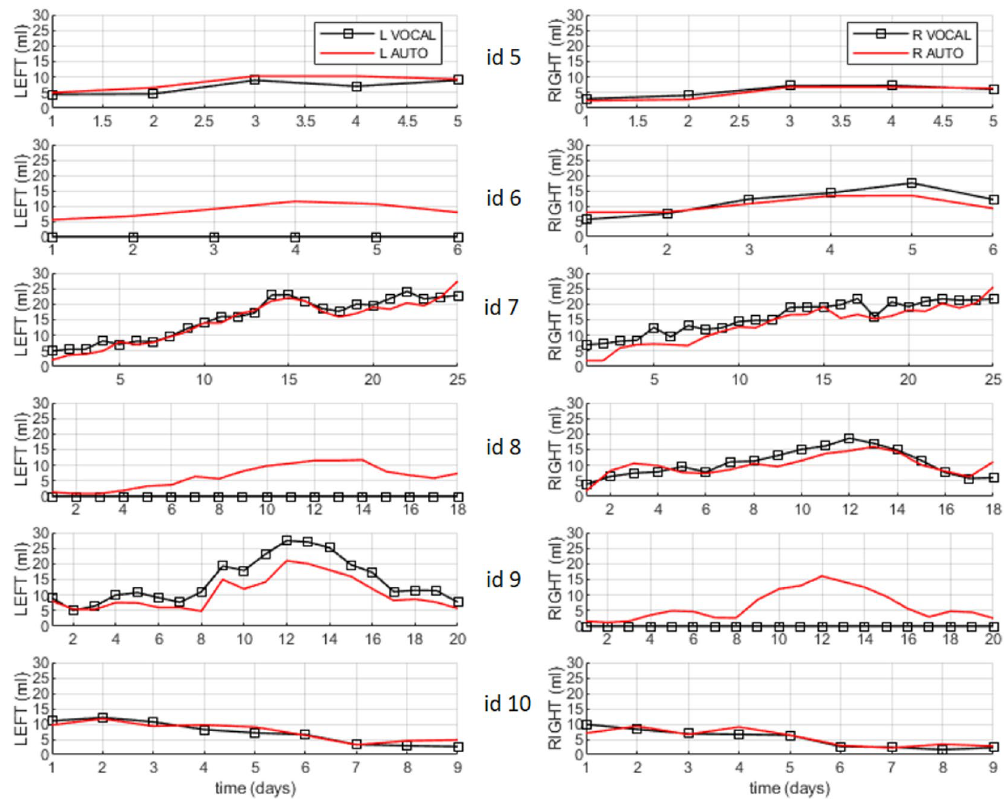
Figure 3. Temporal series acquired over several days of the left (L) and right (R) ventricular volumes of six patients (id5–id10). In total, the six series sum 83 3D US. All of them were used to validate the accuracy of the trained SegNet CNN. The curves with squared markers are the volumes measured using the gold standard, VOCAL. The red curves (without markers) are the measurements obtained with automatic segmentation. Using VOCAL, there are situations in which the ventricles cannot be measured such as the left ventricle of patients id6 and id8, or the right ventricle of